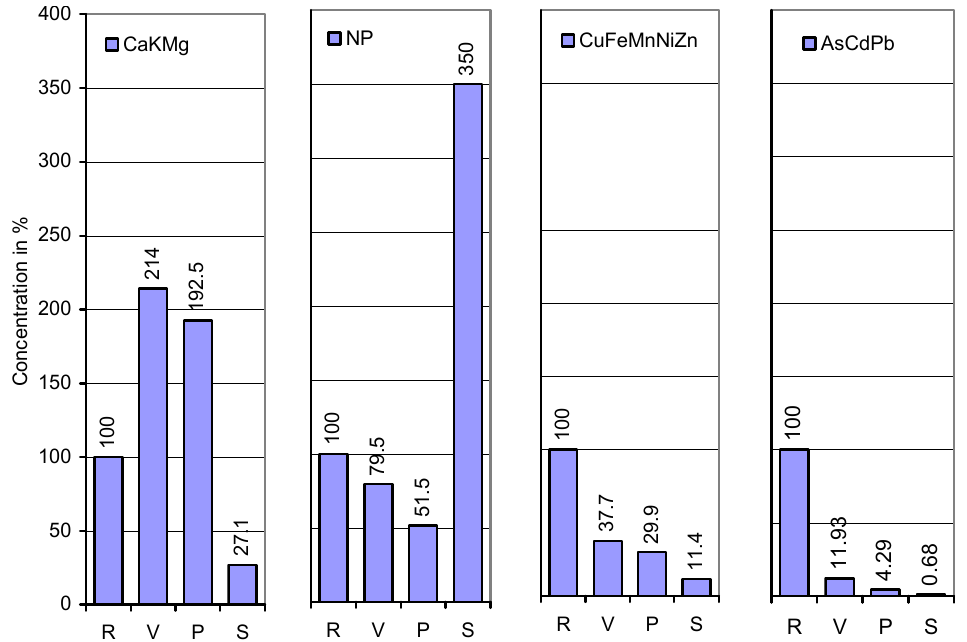
Figure 2. Variation in concentrations of minerals from roots (R) of straw-type pea plants (100%) via upper vine (V) and pod (P) to the whole seed (S). Values are arithmetic means for sets of macronutrients, essential traces, and toxicants with similar modes of passage (refer to Table 2). Adapted from primary data of Gramss and Voigt [18]. Table 2. Up- and down-regulated mineral concentrations (mg kg ´ 1 DW) across the mature plant of pea cv. Rocket grown on the high-contaminated uranium gradient soil A. ( ), quotients calculated from mineral concentrations of the actual to the preceding column expressed in percent.